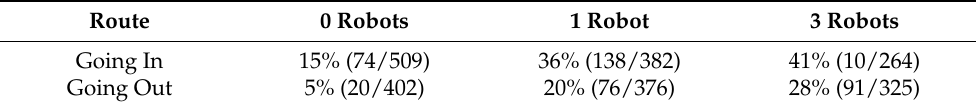
Table 2. Proportion of participants who used the hand sanitizer per